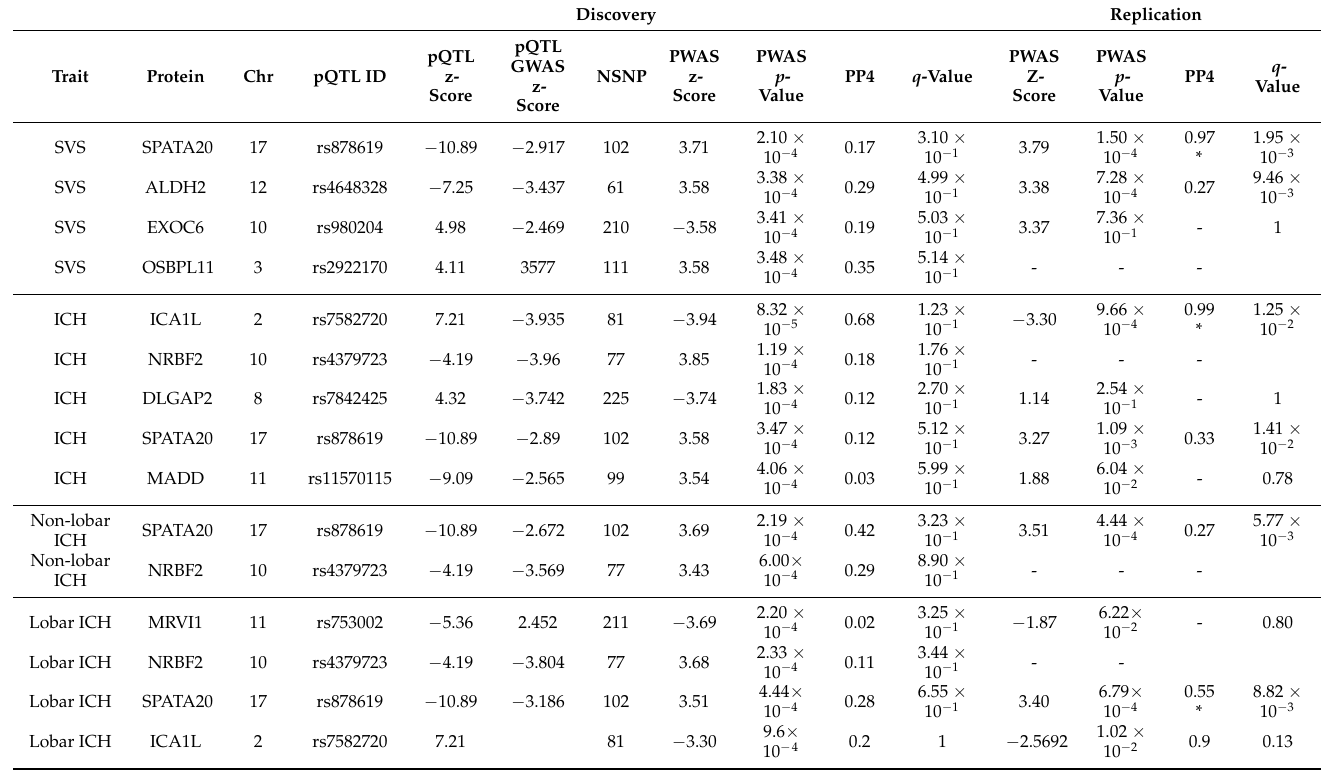
Table 3. PWAS results for the open criteria. The results for the discovery and replication of PWAS associations for proteins with a nominal p -value in the discovery (open criteria). Discovery